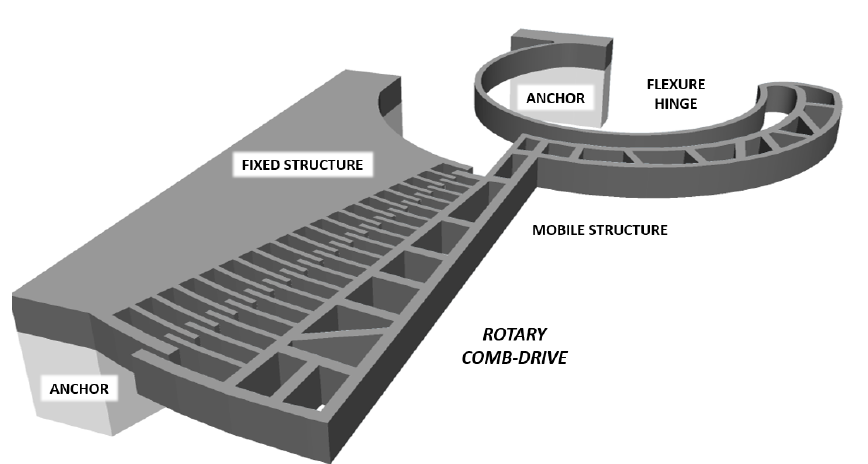
Figure 1. Top view of the proposed device.